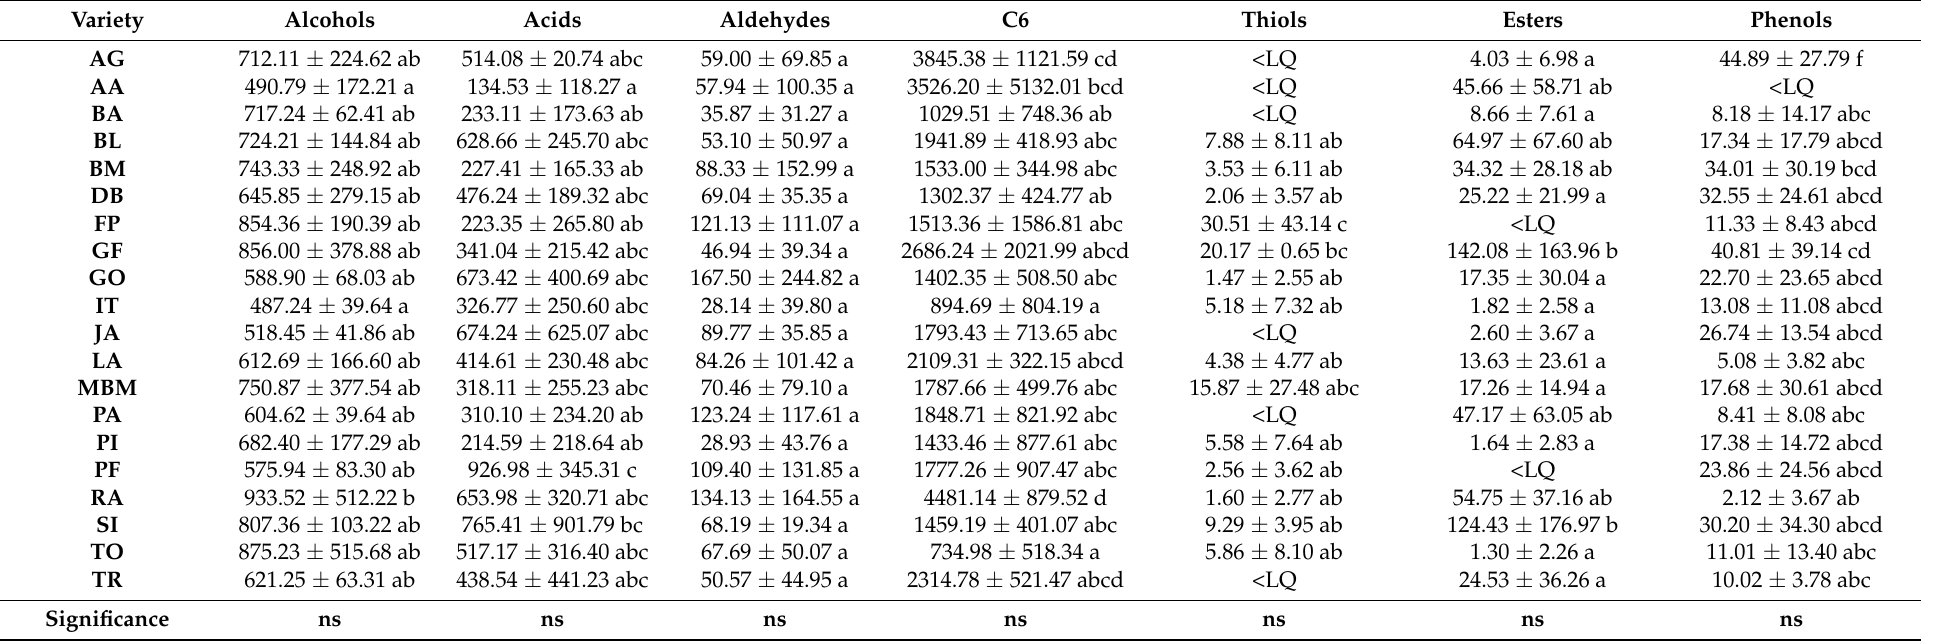
Table 2. Free volatile compounds (all values are expressed as µ g · L − 1 to allow for comparisons among